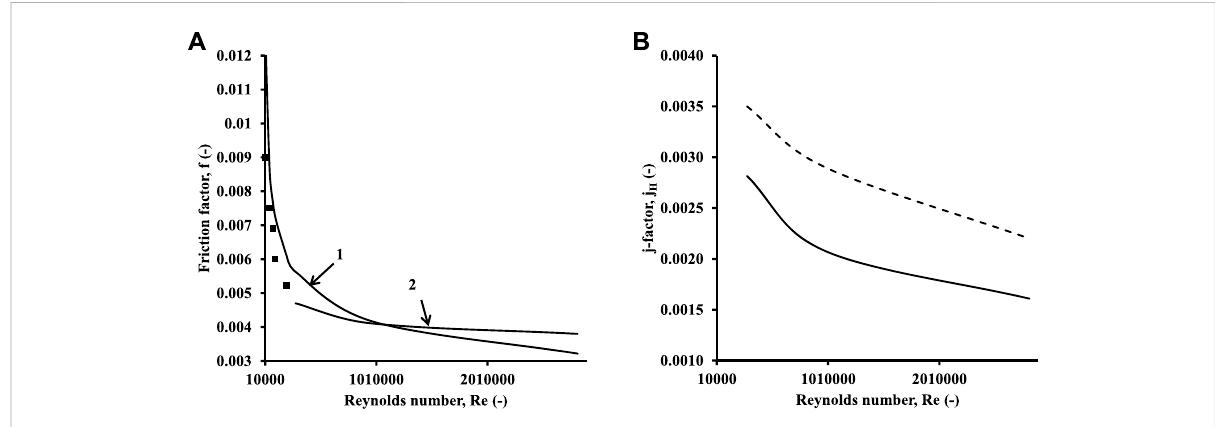
FIGURE 11 Friction factor and j-factor variation with Re for the without-distributor case. (A) Friction factor data prediction: 1) correlation and 2) CFD. SymbolsdenoteexperimentaldataofGandhietal.(2012). (B) j-factorvs. Re .Boldline:presentwork.Dottedline:j-factorforthetube-sideoftheshell and tube heat exchanger (Sinnott and Towler,